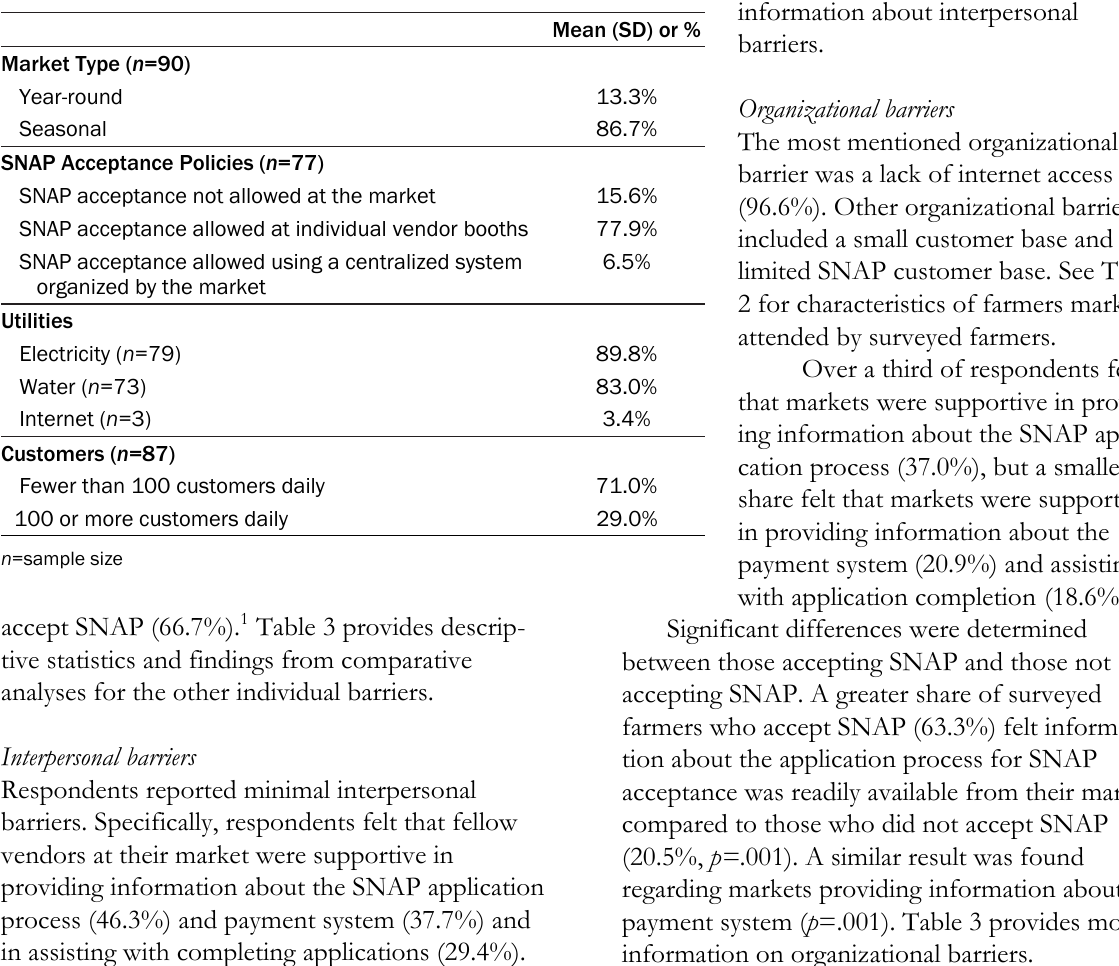
Table 2. Demographic Characteristics of Farmers Markets Attended by Surveyed